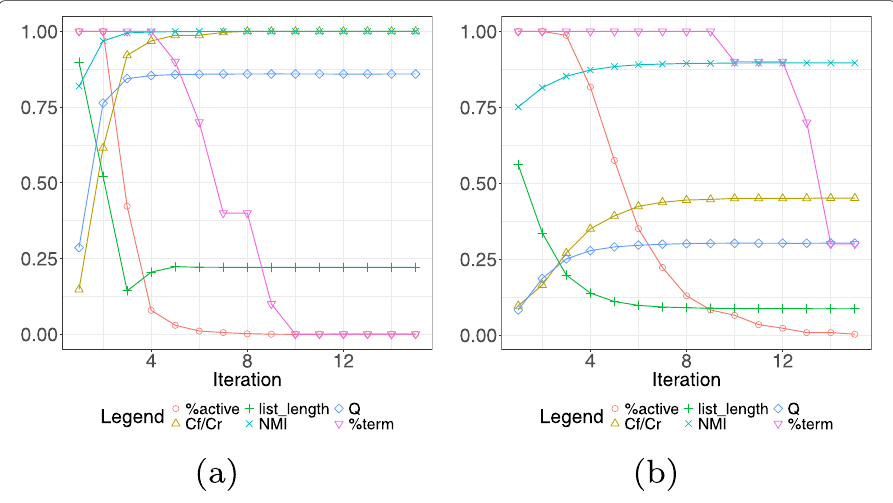
Fig. 5 Experiments on the LFR benchmark. μ = 0.1 ( a ) and μ = 0.6 ( b ) has been used for the two experiments. On the x-axis you can find number of iterations. On the y-axis NMI, modularity, ratio between number of communities found by MemLPA and real communities, percentage of runs that terminated, number of active nodes and average ratio between memory length and node degree. Both experiments have been run 50 times and results